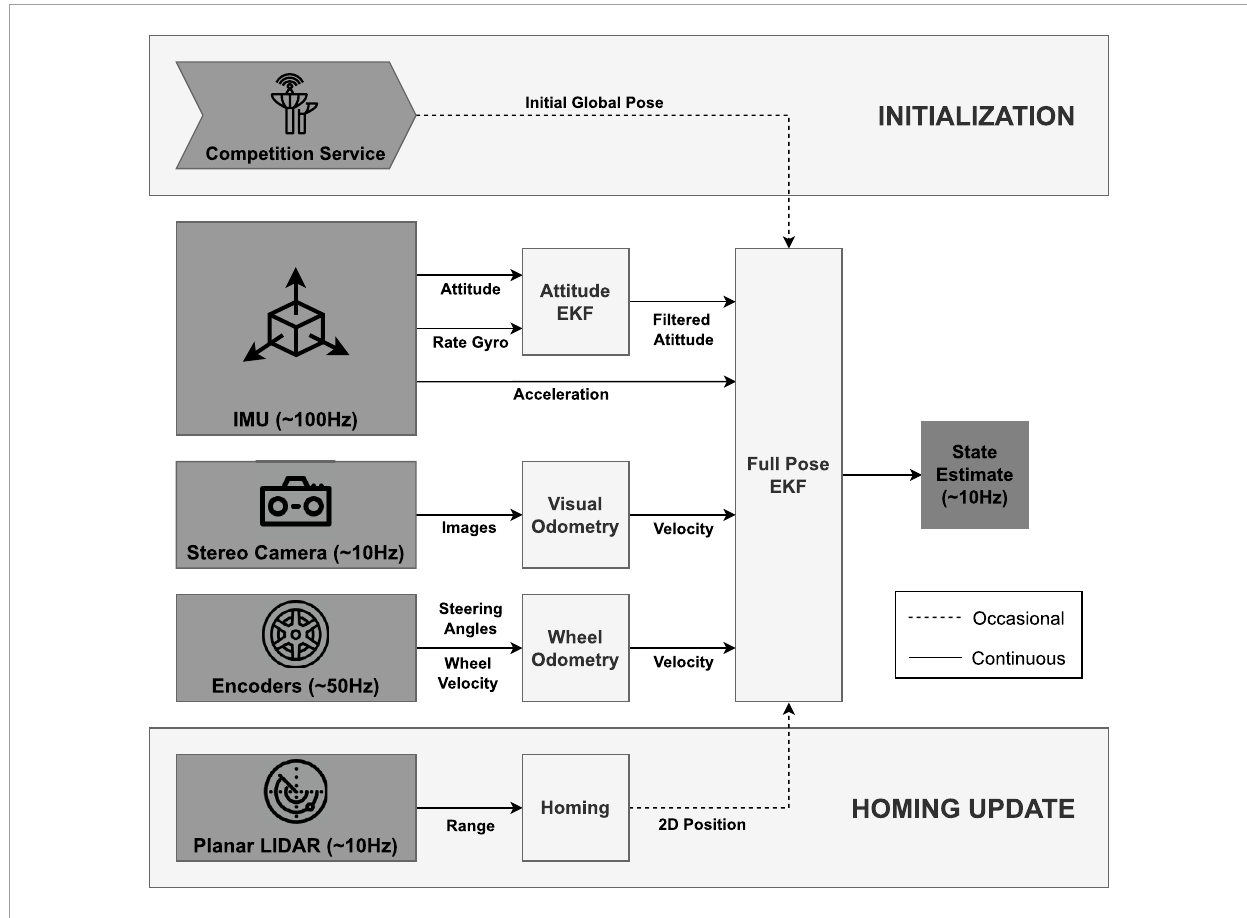
FIGURE 3 The architecture of the state estimation framework as is in our previous work (Kilic et al., 2021). Initialization of the state of each rover was performed at the beginning of a competition run. A homing update was performed periodically to improve localization estimation. A standalone EKF was dedicated to providing a filtered attitude estimation. Velocity information from the wheel and stereo camera is used in a sensor fusion EKF to provide the rover velocity and position estimations. Finally, rover full state estimation (attitude, velocity, position) was generated by the combination of the data coming from these two different